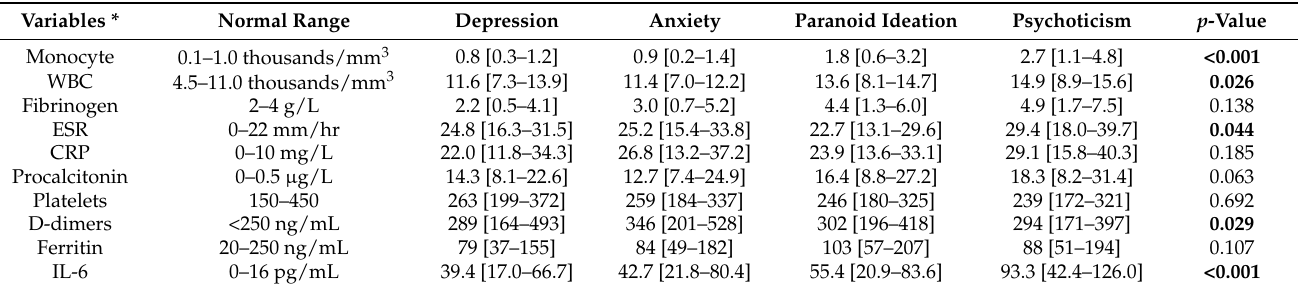
Table 5. Comparison of laboratory parameters stratified by psychological symptoms on the SCL- 90 scale.